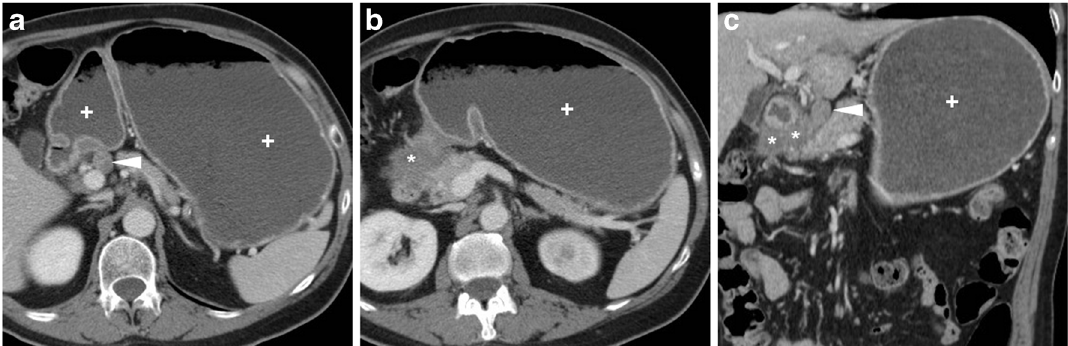
Fig. 13 In a 77-year-old male, obstructing duodenal carcinoma appeared at CT as an eccentric, poorly enhancing tissue (*) abutting the proximal duodenum, causing upstream gastric fluid-filled dilatation (+). Note adjacent round-shaped solid lymphadenopathy